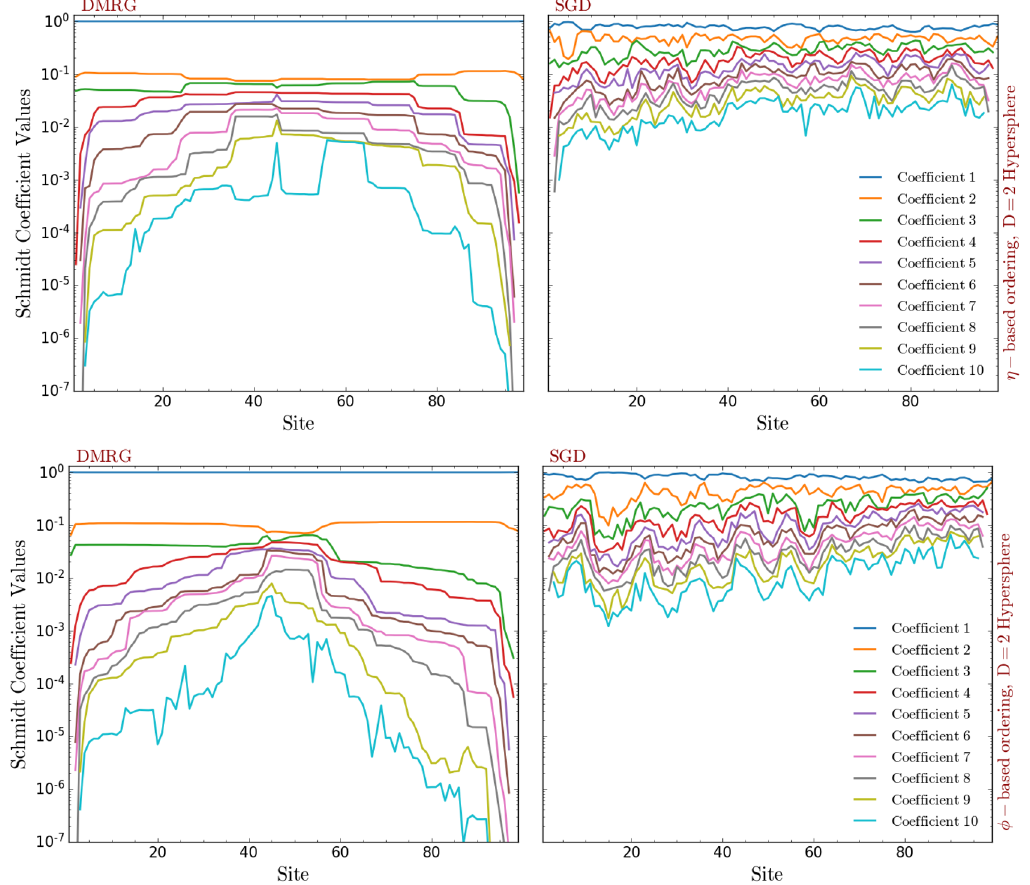
Figure 14 . The upper two panels show the Schmidt Coefficient distributions for η -based ordered MPS where the left panel used for MPS trained by DMRG and the right panel for SGD algorithms. The bottom two panels show the same for φ -based ordered